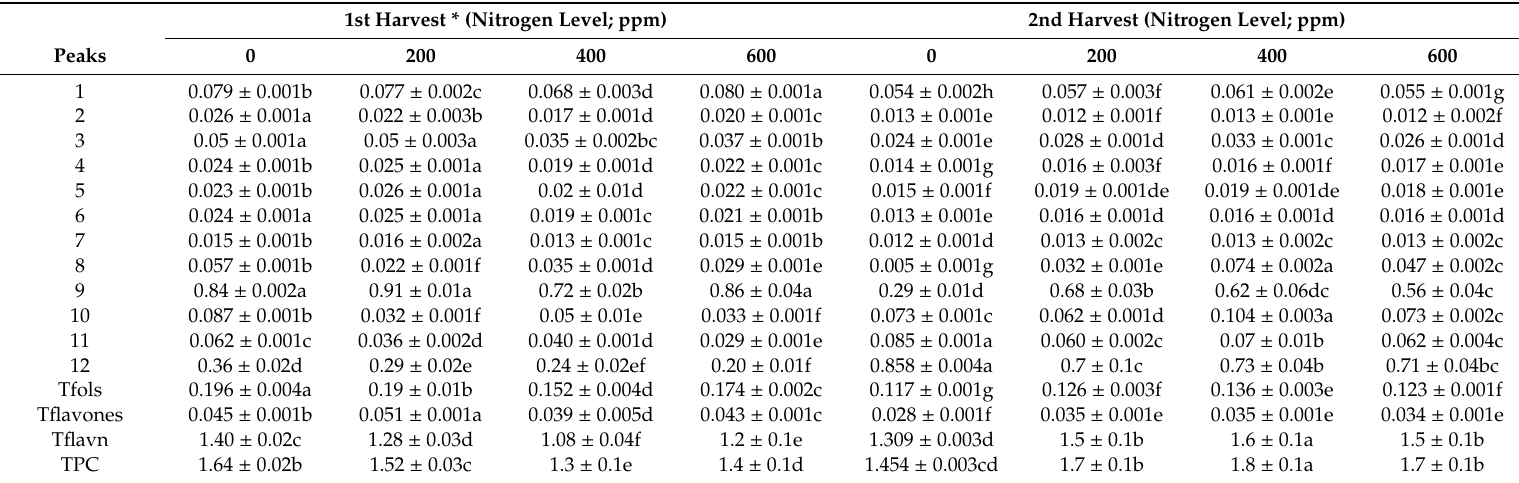
Table 8. Quantification (mg / g of plant fw) of the phenolic compounds present in the hydroethanolic extracts of Centaurea raphanina subsp. mixta plants grown in 2 L pots under greenhouse conditions, in relation to harvesting time (1st and 2nd harvest) and nitrogen level (0–600 ppm) (mean ± SD, n =